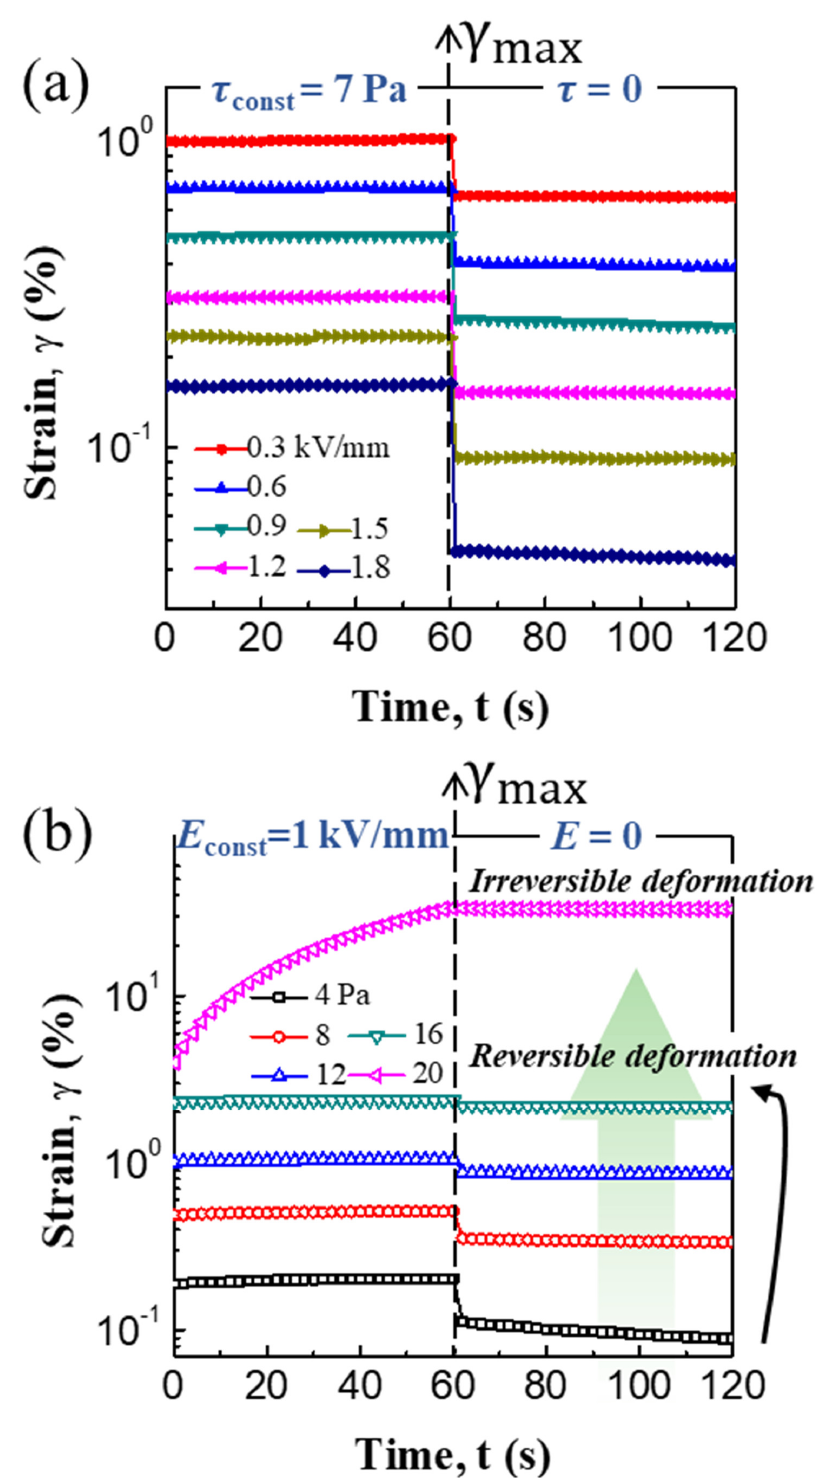
Figure 11. Strain vs. time under ( a ) constant stress and ( b ) constant electric field strength of GO/PDPA microsheet composites-based ER fluid (10 vol.%).